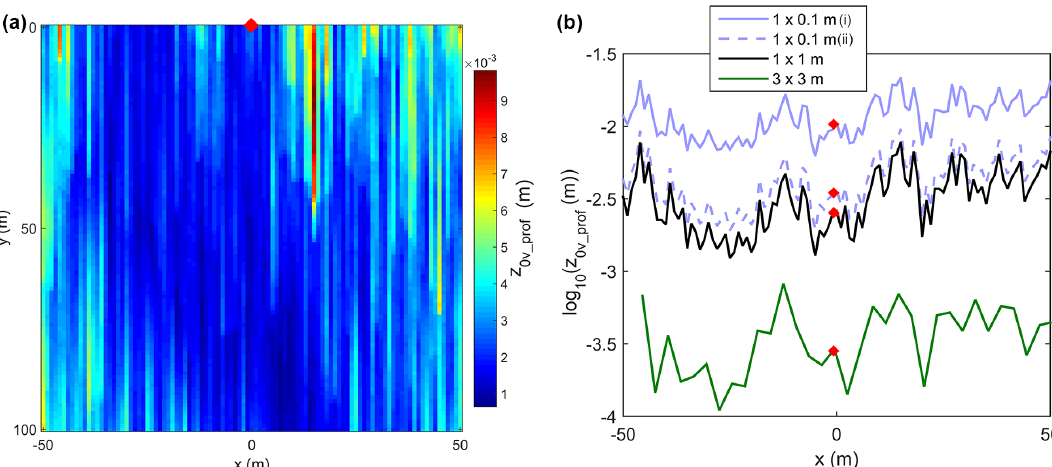
Figure 10. (a) z 0v_prof values estimated for each grid cell in a 101 × 101m area upwind of CG16-1 (red diamond) from the September 2016 DEM of Conrad Glacier. (b) z 0v_prof values derived for the downslope profiles at CG16-1 ( x = 0) and for the grid cells 50m to the east and west of the station from the original DEM (1 × 1m) and from the higher- (1 × 0 . 1m) and lower- (3 × 3m) resolution DEMs constructed for sensitivity testing. The 1 × 0 . 1m (i) values are from the initial high-resolution DEM used in the sensitivity test, while the DEM used for 1 × 0 . 1m (ii) had the amplitude of the synthetic microtopography profiles reduced by a factor of 10.